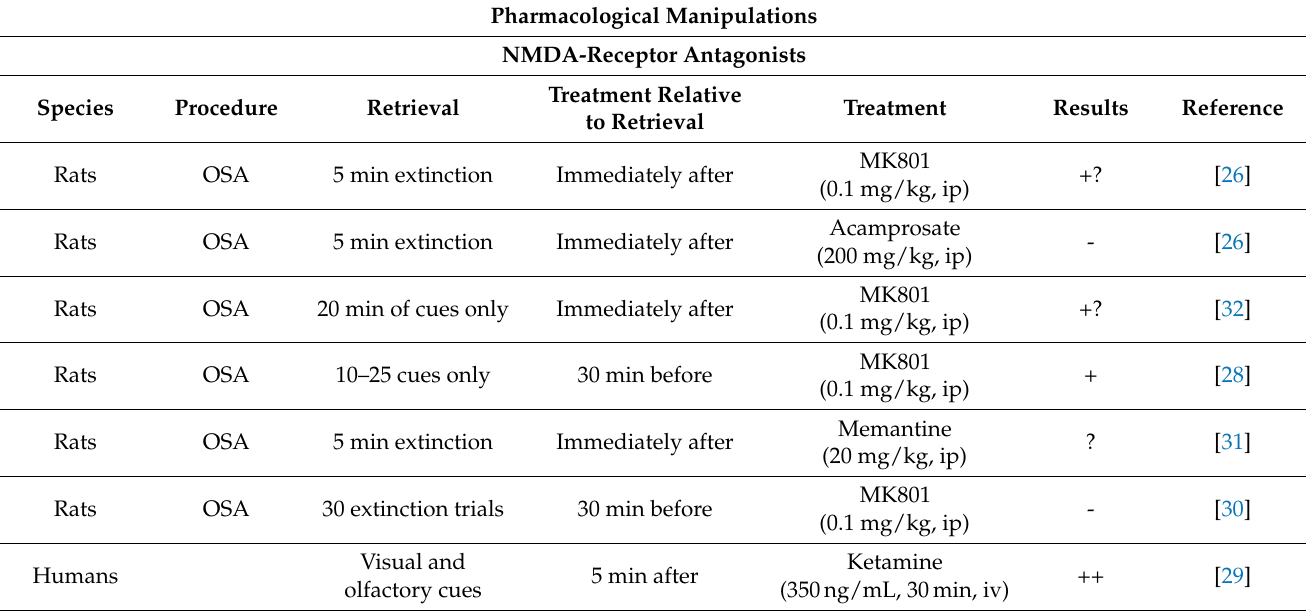
Table 1. Interference with alcohol-memory